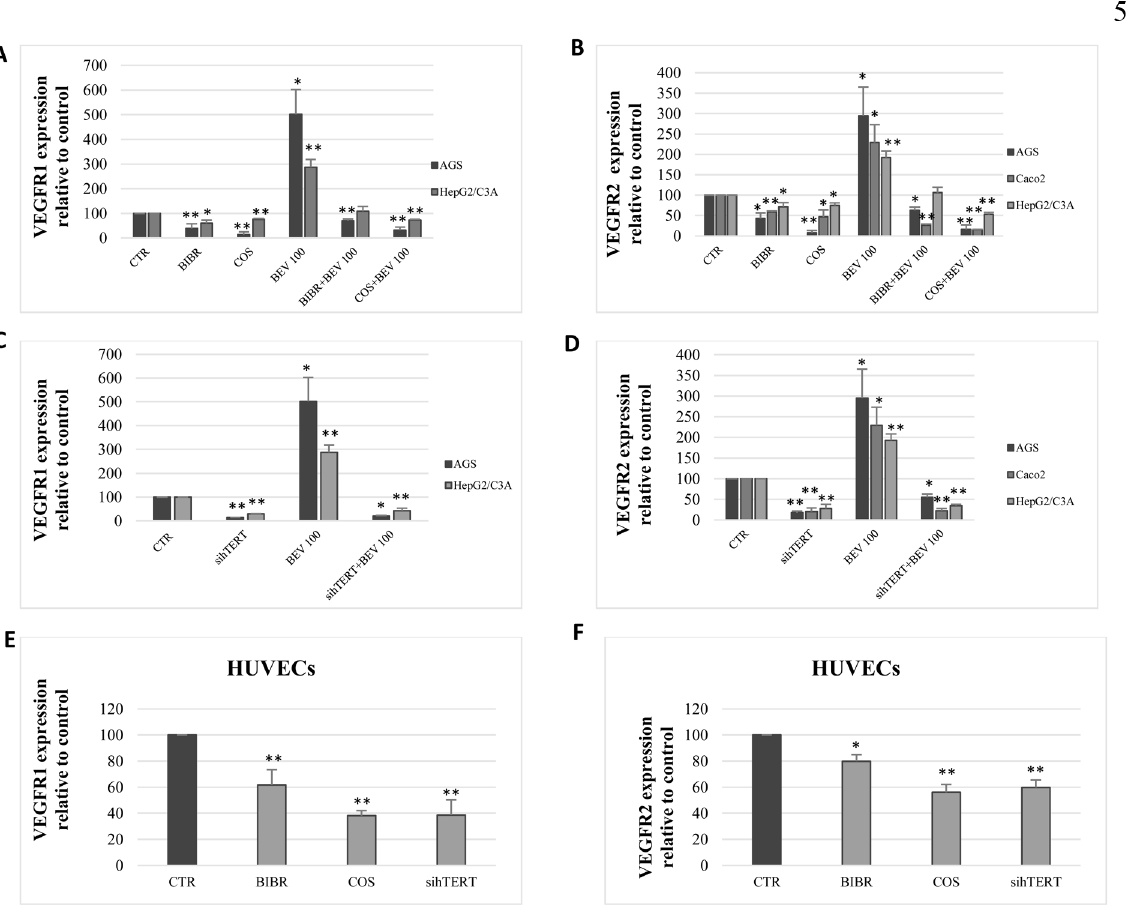
According to our results, telomerase regulates VEGFR1 and VEGFR2 expression in gastroin- testinal cancer cells. Hence, we evaluated VEGFRs’ response to telomerase inhibition and over- expression in HUVECs. Our results showed that telomerase inhibition with BIBR-1532 and costunolide and hTERT siRNA significantly decreased VEGFR1 and VEGFR2 expression (p < 0.05) (Fig 5E and 5F) and protein levels (p = 0.01) (Fig 6A). Moreover, hTERT